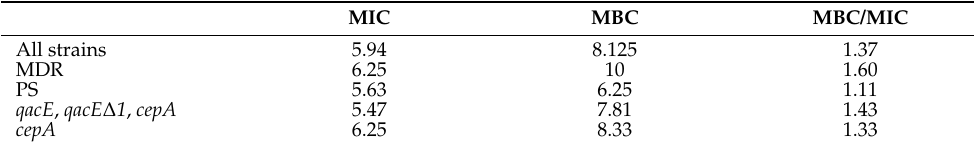
Table 3. Average MICs and MBCs of A. baumannii strains following ethanol exposure.